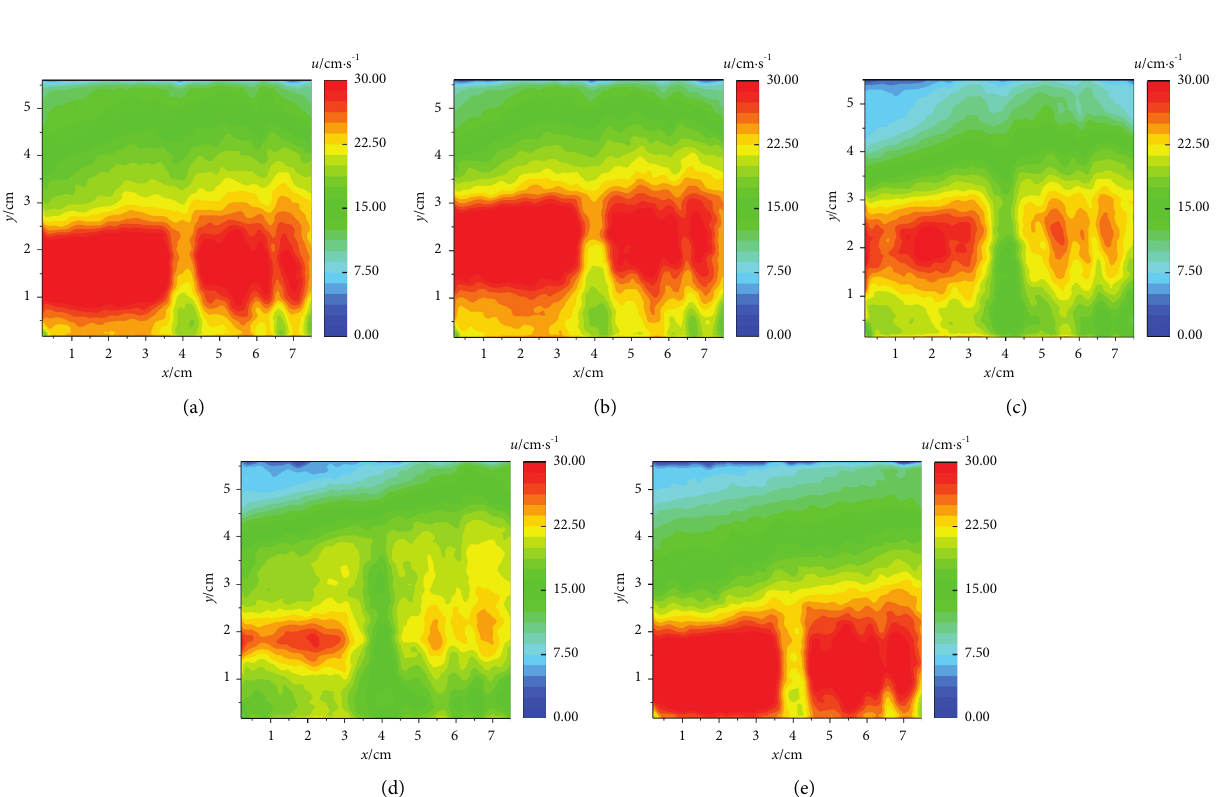
Figure 11: The distribution of the lateral turbulent intensities in different working conditions. (a) H25-1, (b) H25-1.2, (c) H25-1.5 (D252), (d) D251, and (e)